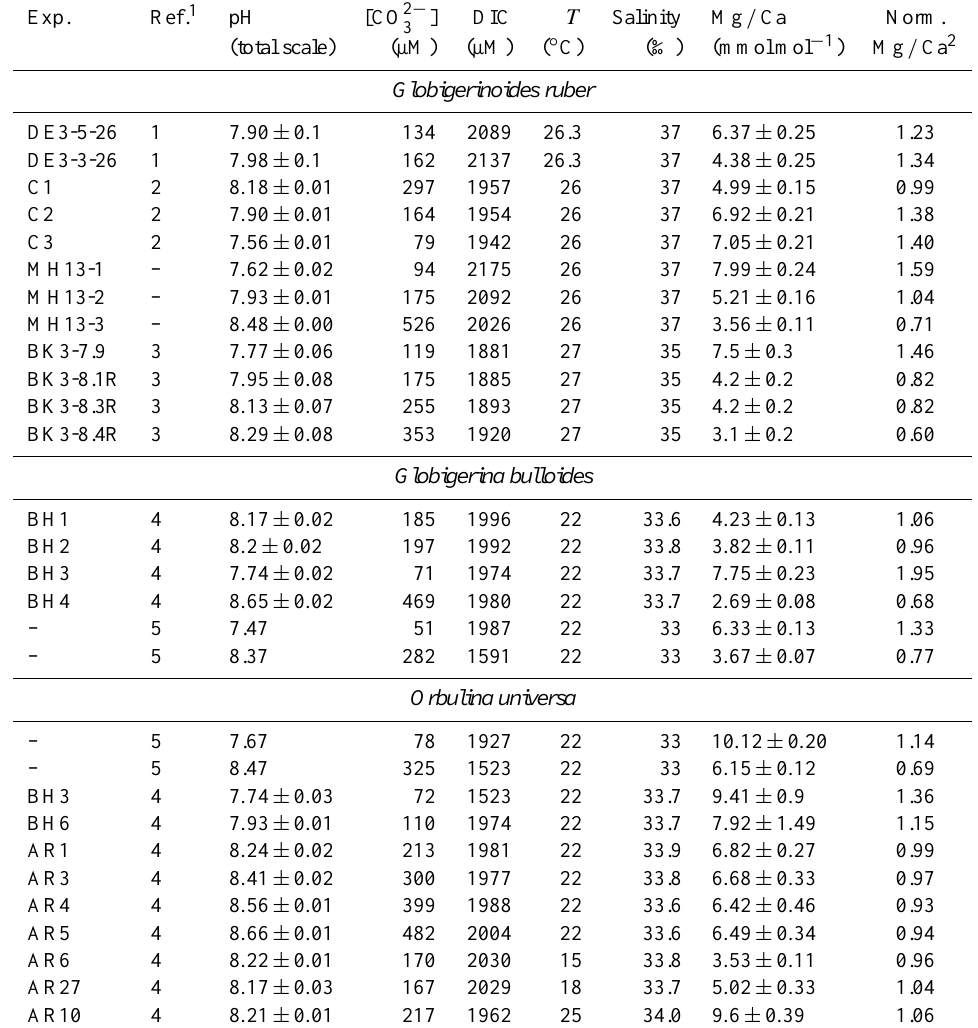
Table 1. New and compiled foraminifera culture data of the relationship between shell Mg / Ca and seawater carbonate chemistry. Values are given to the precision originally reported.